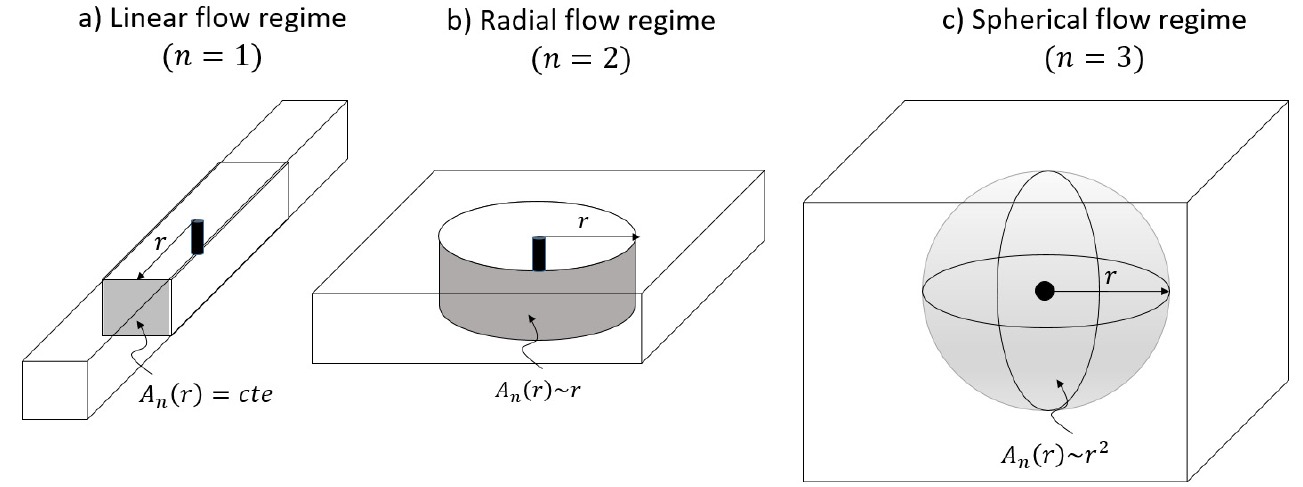
Figure 2. Examples of flow geometries for integer flow dimensions: ( a ) one-dimensional flow within a plane ( n = 1 and v = 1/2 ); and ( b ) two-dimensional flow within a cylinder (well) ( n = 2, v = 0 ); and ( c ) three-dimensional flow within a sphere ( n − 3, v = − 1/2 ).